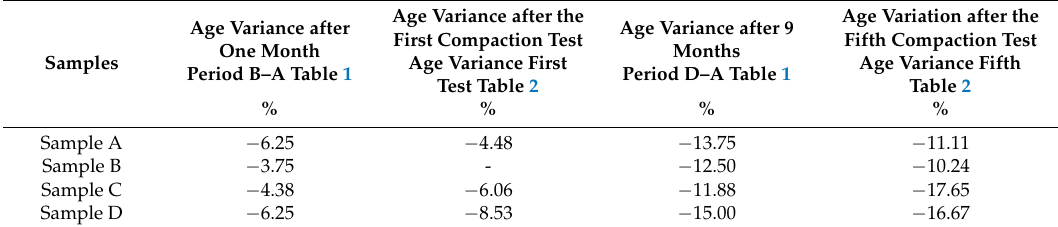
Table 3. Comparison between the results obtained from samples subjected to natural compaction (A16, B16, C16 and D16 (Table 1)) and samples subjected to pneumatic compaction (A14, B14, C14 and D14 (Table